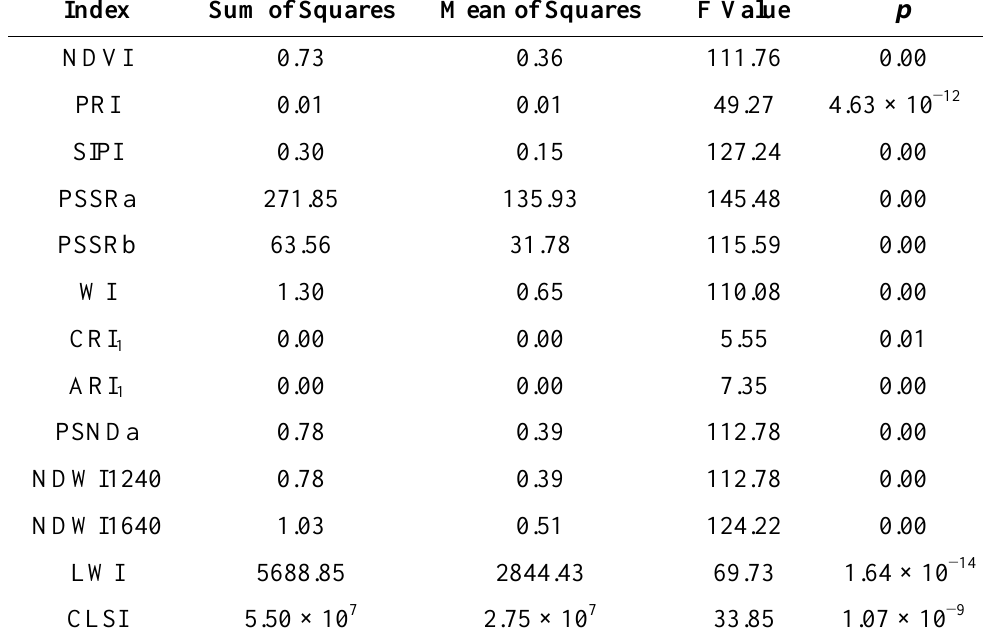
Table 2. Correlation of vegetation indices to visual disease scoring using 2nd degree polynomial